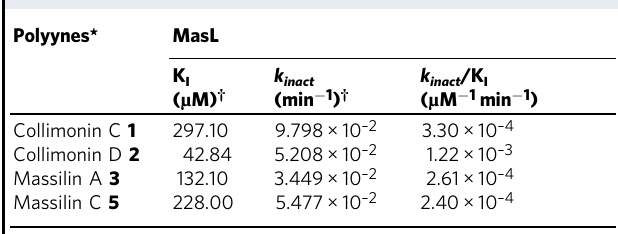
Table 1 Inhibition kinetic of Massilia sp. YMA4 MasL by polyynes.